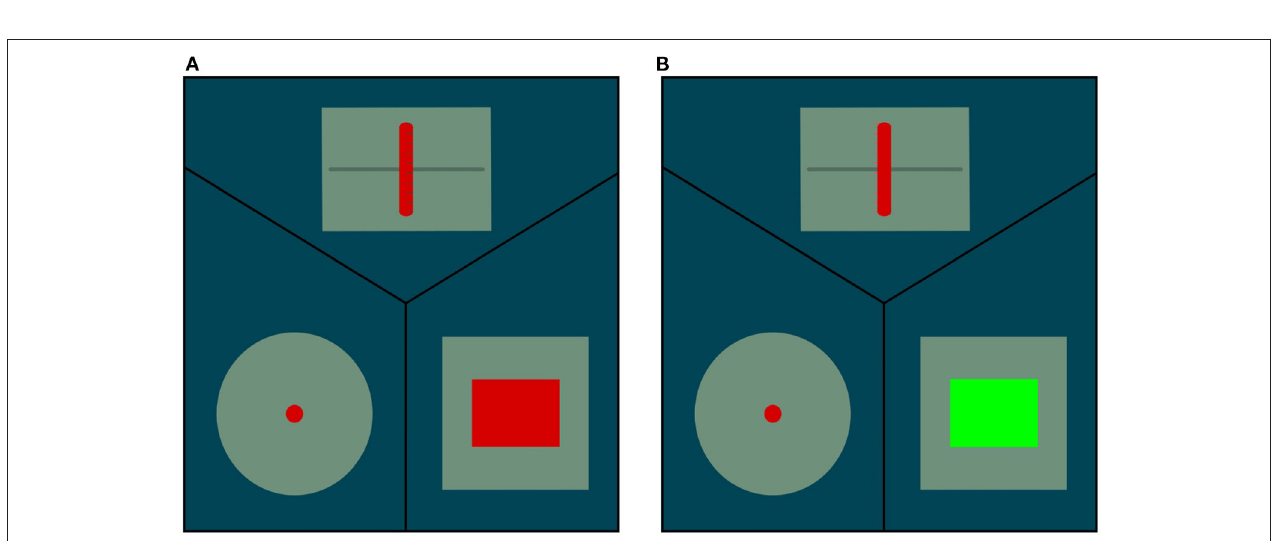
Figure 8 is a collection of pictures representing the objects used in the experiments: 3 bowls in a pile, 3 mugs in a pile, two different toy locomotives, Duplo bricks, two identical wooden cubes, and 5 buttons. Of course, the pile of bowls and mugs (see Figures 8C,D ) can be dismantled during an experiment. The Duplo bricks are of different colors (red in the Figure 8E ): green, red, purple, orange, yellow. There are five buttons, all are visible in Figure 7 : circular blue (the one in Figure 8H ), red, yellow, green and squared green. Figure 8 indicates in bold for each object its expected